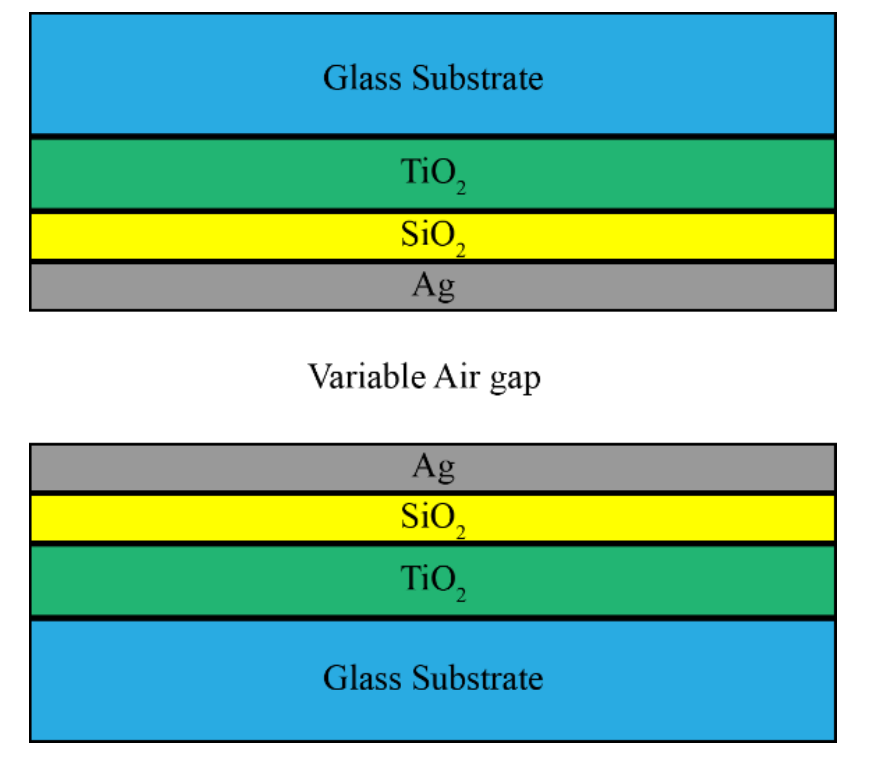
Figure 2. Schematic representation of the filter’s layers.